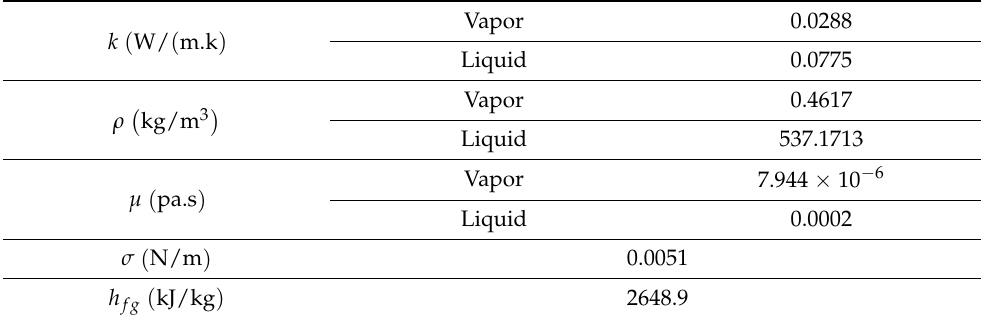
Table 5. Thermophysical properties of working